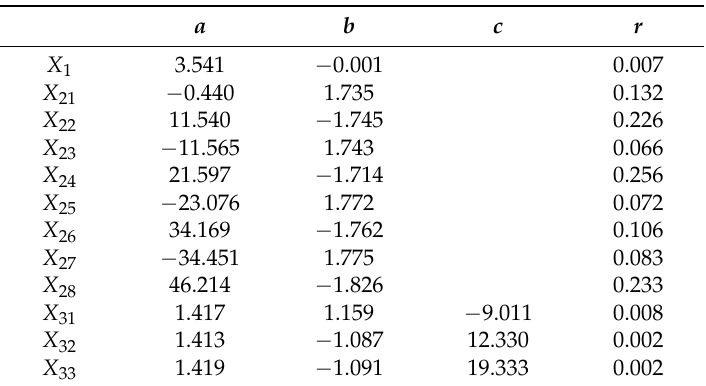
Table 2. Coefficient of regression